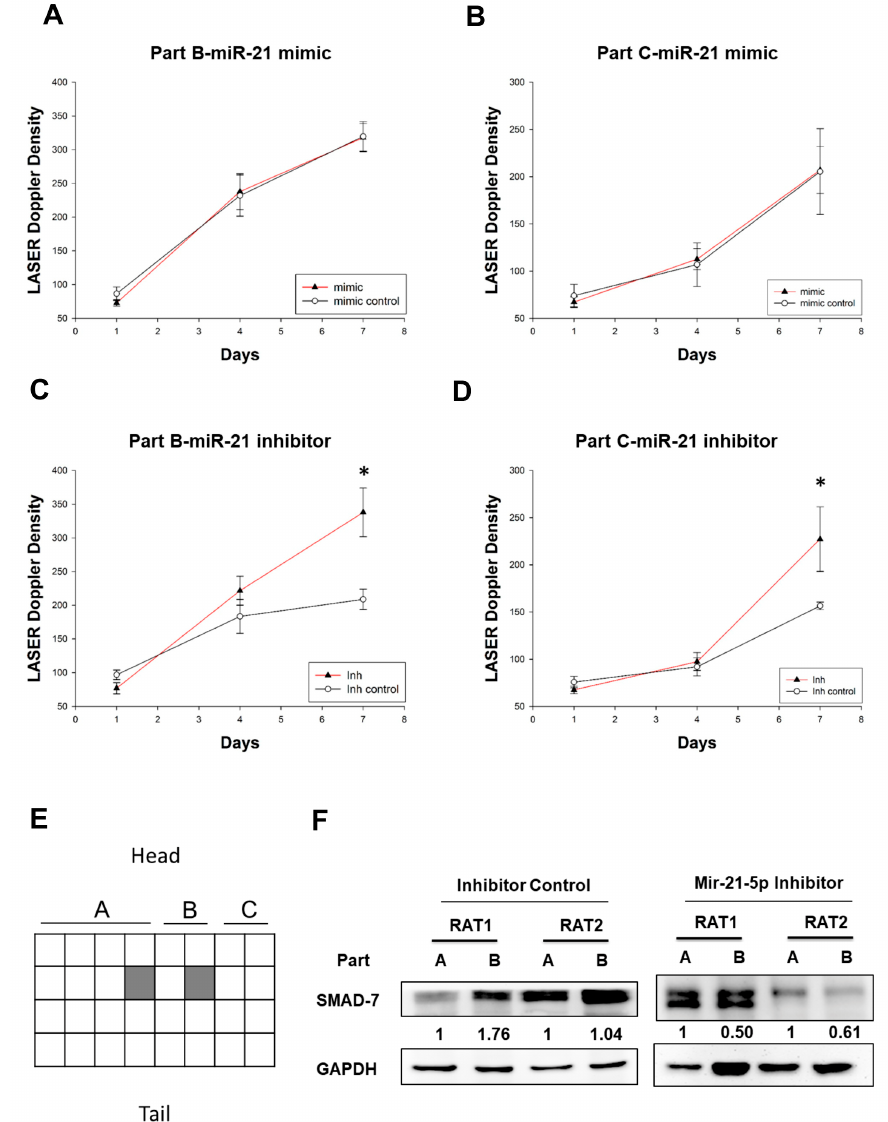
Figure 5. Treatment of inhibitor miR-21-5p enhances blood flow in the rat model. The density of laser Doppler angiography image was illustrated at day 7 post operation (shown as Figure 1F). Meanwhile, each square was outlined and calculated as the mean of the angiogenesis density of the corresponding region (including Part B and Part C). Angiogenesis of ( A ) Part B and ( B ) Part C of skin flap after subdermal local injection of mimic miR-21. Angiogenesis of ( C ) Part B and ( D ) Part C of skin flap after subdermal local injection of inhibitor miR-21 into Part B. The results were analyzed by laser Doppler on day 1, day 4, and day 7 post-miR injection, * p < 0.05, significant difference between two groups at day 7 post miR injection, * p < 0.05, significant difference between two groups at the same day ( n = 6 in each group); ( E ) The illusion of rat skin. The Part A and Part B was divided into 16 and 8 regions, respectively. The protein of rat skin was collected from the shading region of Part A and Part B in miR-21-5p inhibitor- and miR-21-5p inhibitor control-treated rat at day 7 after flap operation; ( F ) SMAD7 protein expression in rat skin. RAT1 and RAT2 indicate two independent rat from each group ( n = 2). Symbol mimic: miR-21-5p mimic; Inh: MiR-21-5p inhibitor; Inh control: Inhibitor control.